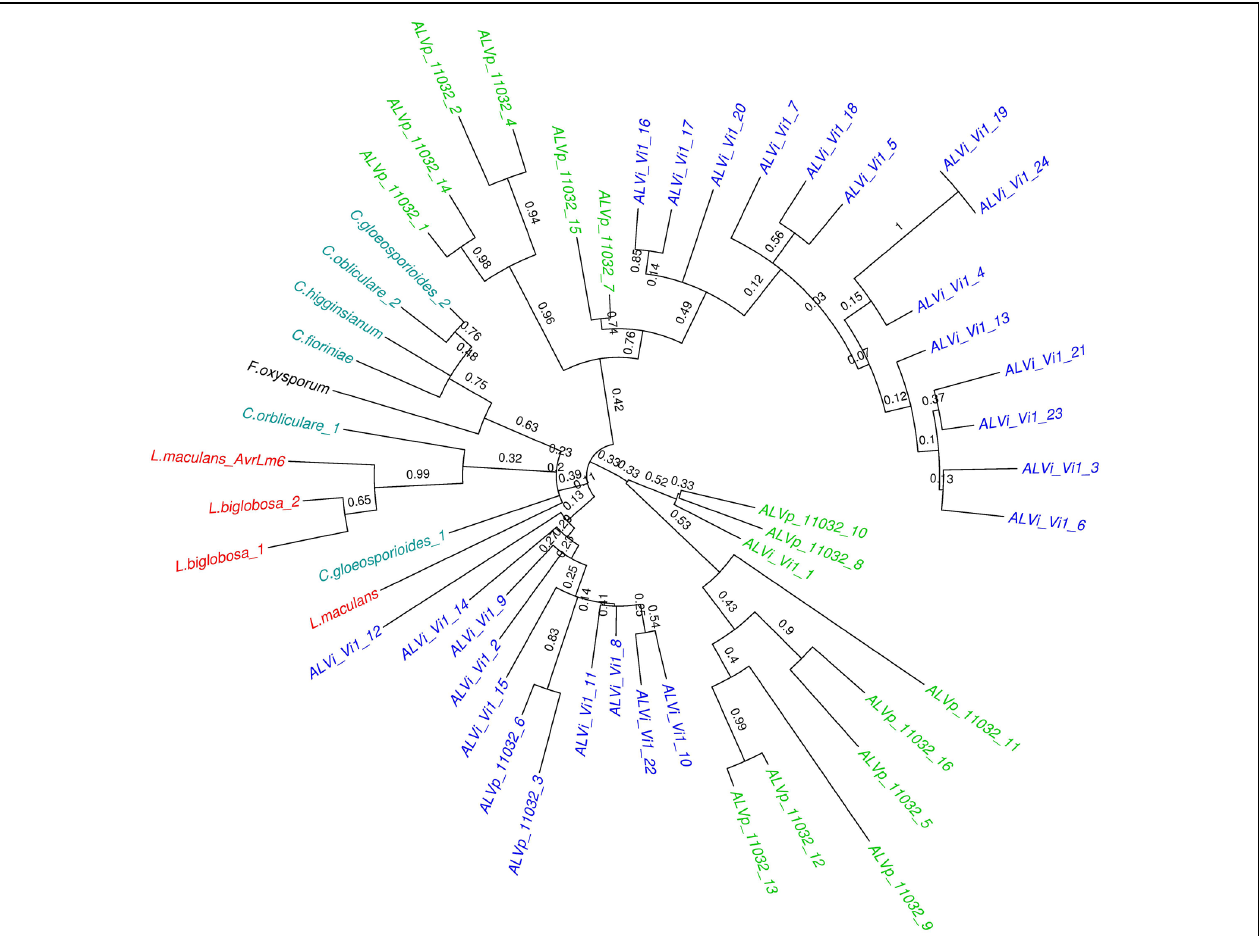
FIGURE 4 | Maximum likelihood tree calculated on multiple sequence alignment of all ALVi and ALVp predicted protein sequences from V. inaequalis isolate Vi1 and V. pirina isolate 11032 as well as AvrLm6 (GenBank: CAJ90695) and a paralogue from L. maculans and homologs from C. gloeosporioides (GenBank:XP_007281214.1 and XP_007275717.1), C. higginsianum (CCF39162.1), C. orbliculare (ENH83850.1) and (ENH87246.1) and F. oxysporum (EXK76127.1) using a WAG substitution model and 1000 bootstrap tests. Sequence names in green are from V. pirina isolate 11032 and blue from V. inaequalis Vi1, red are from Leptosphaeria species, teal are Colletotrichum species, and black is Fusarium oxysporum